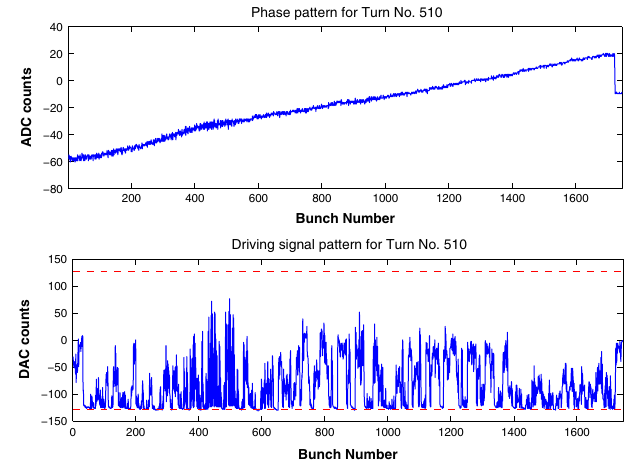
FIG. 13. (Color) Front-end and back-end signal of the longitu- dinal feedback system for turn 510 of the time sequence shown in Figs. 8 and 9. At this interval the kick signal is largely saturated at the negative full-scale value of (cid:2) 128 .